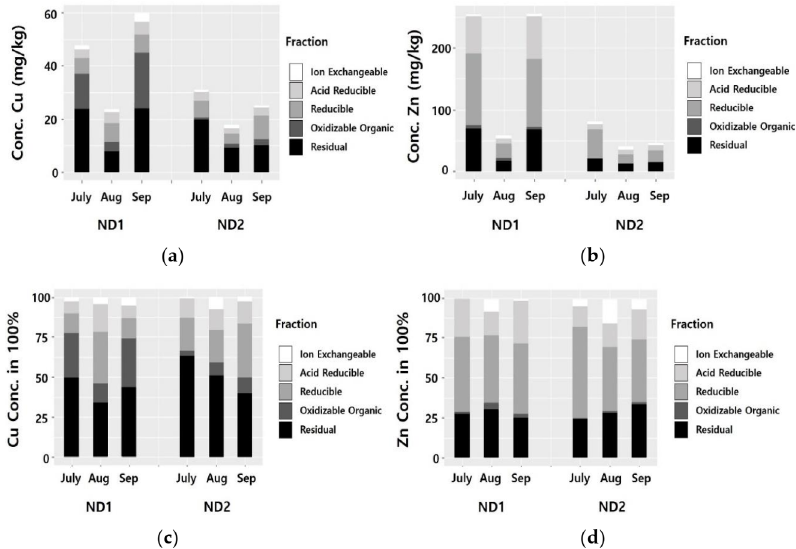
Figure 6. Results of sequential extraction: (1) Concentration of each fraction of sequential extraction for ( a ) Cu and ( b ) Zn, (2) Concentration in each fraction of sequential extraction expressed as a percentage of the total concentration for ( c ) Cu and ( d )